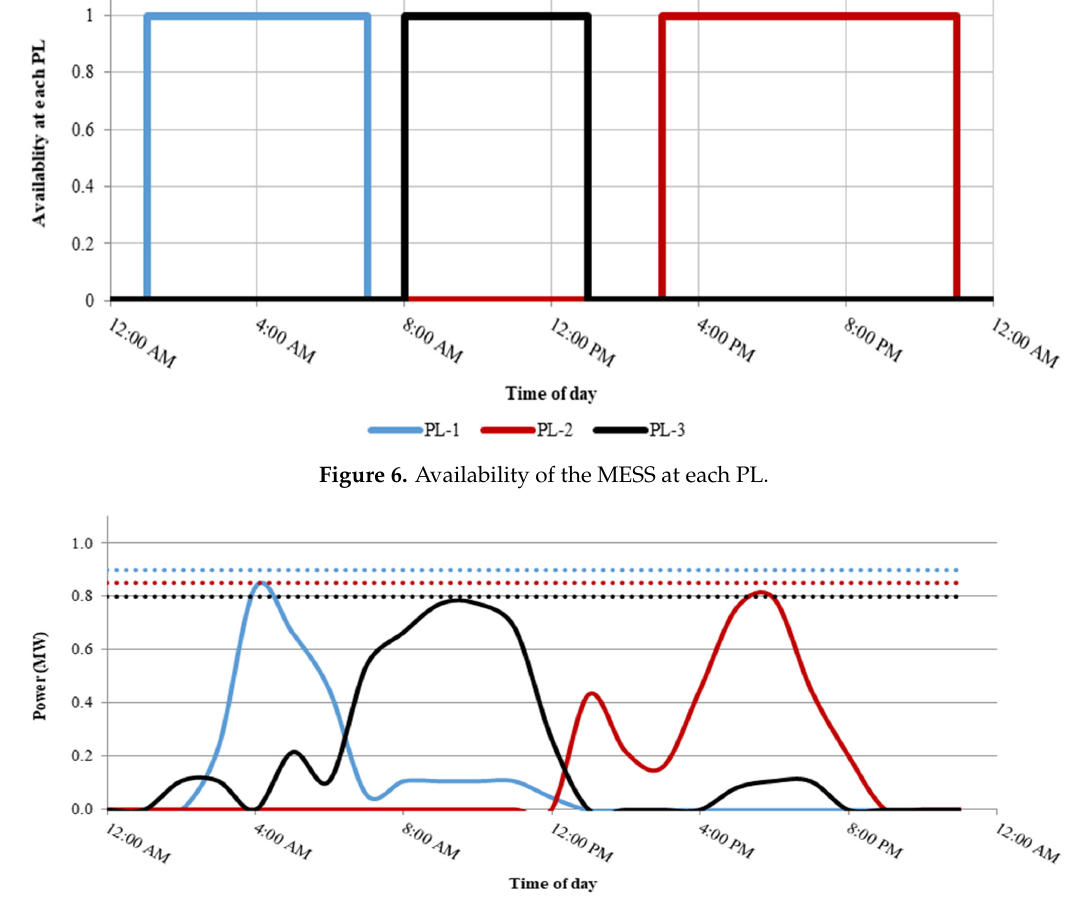
Figure 7. Power demand of each PL after MESS visits.